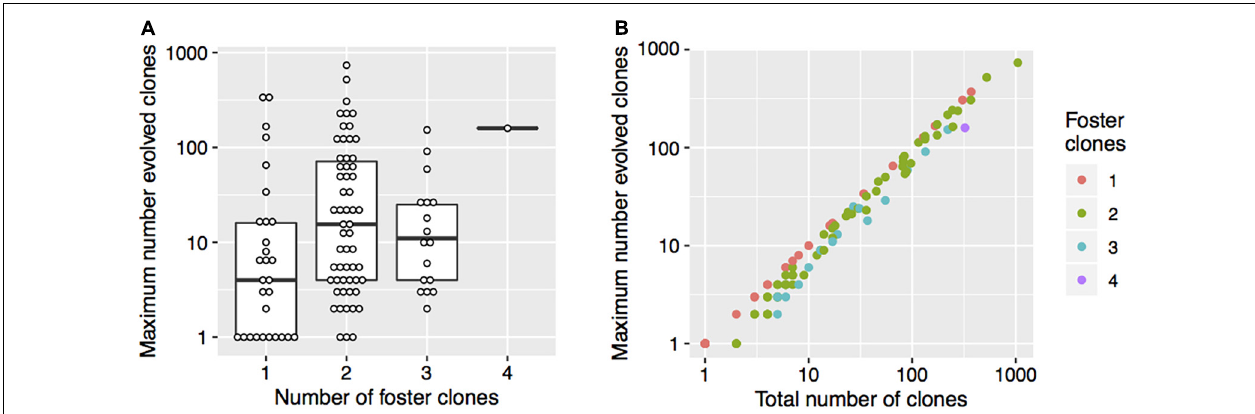
FIGURE 2 | The number of foster clones, the maximum number of evolved clones, and the total number of clones. (A) The thick horizontal lines represent the medians and the boxes indicate the first and the third quartiles of the maximum number of evolved clones. Each point shows data for one patient. (B) The colors indicate the number of foster clones. Each point shows data for one